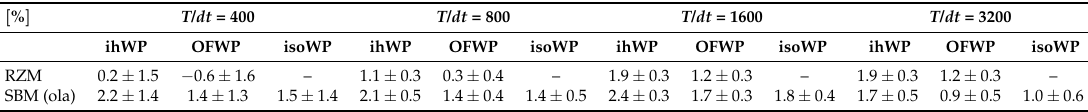
σ ¯ (cid:101) between target and resulting wave height for the five different NWMs at Table 12. Error ¯ (cid:101) ¯ H ± ¯ H different locations along the